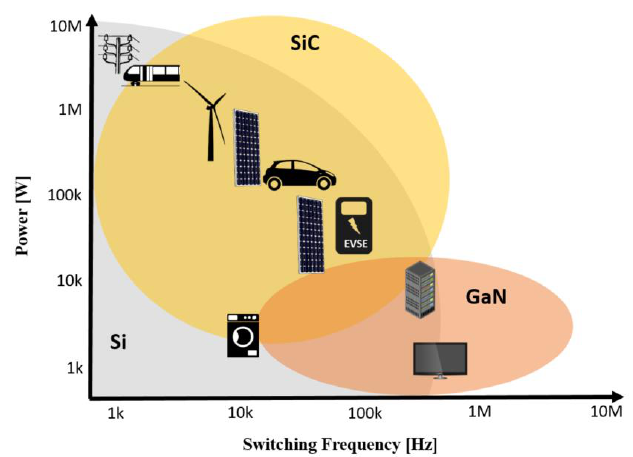
Figure 5. Switching frequencies of Si, SiC and GaN